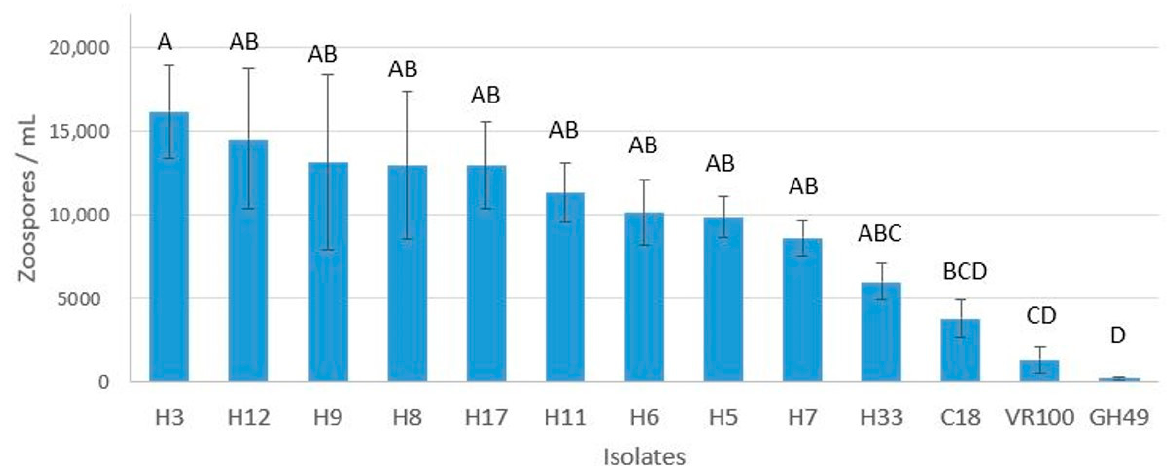
Figure 4. Zoospore production per cm 2 of colony. Mean concentration of zoospores produced by Phytophthora palmivora isolates pathogenic on cacao. Isolates sharing the same letters above the bars are not significantly differ ( p ≤ 0.05). Bars represent standard errors.